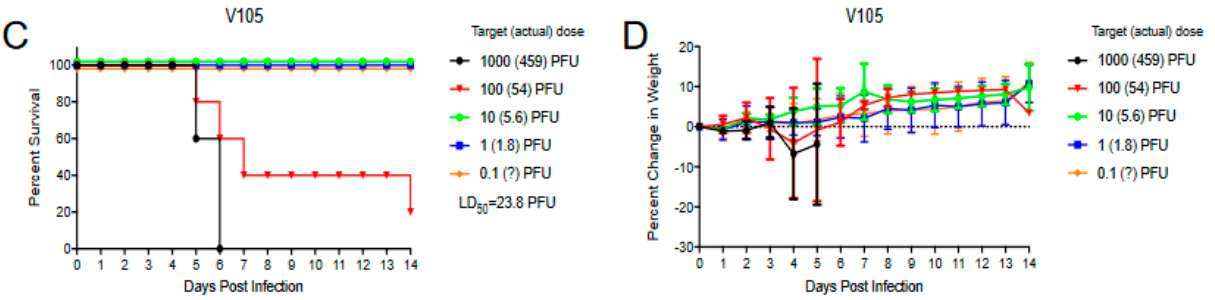
Figure 9. Aerosol LD 50 mortality curves ( A , C ) and weight loss data ( B , D ) for 4–week–old CD–1 mice infected with each indicated virus. Values with question marks are estimates of aerosol dose based on virus dilution. Aerosol LD 50 infections included 5 or 10 mice per group and were replicated with at least four dilutions per experiment. Error bars are standard deviations.